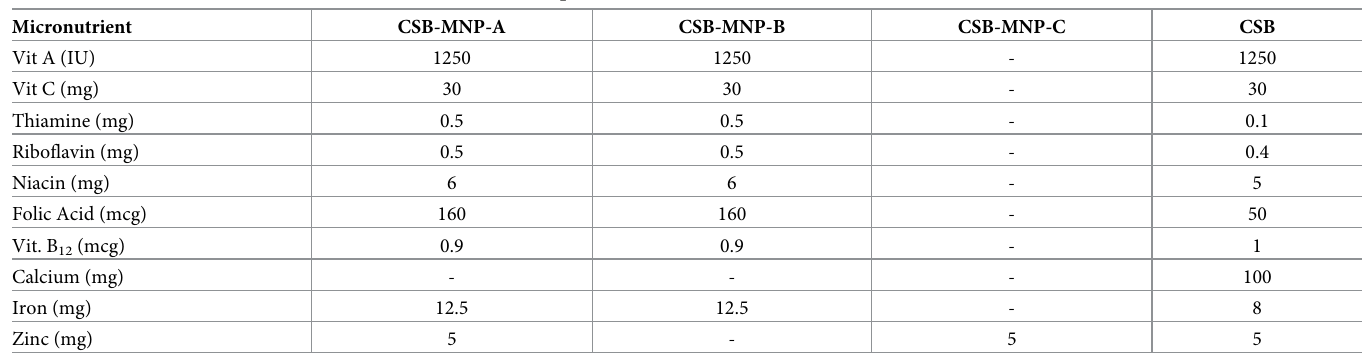
Table 1. The micronutrient fortification levels of the intervention